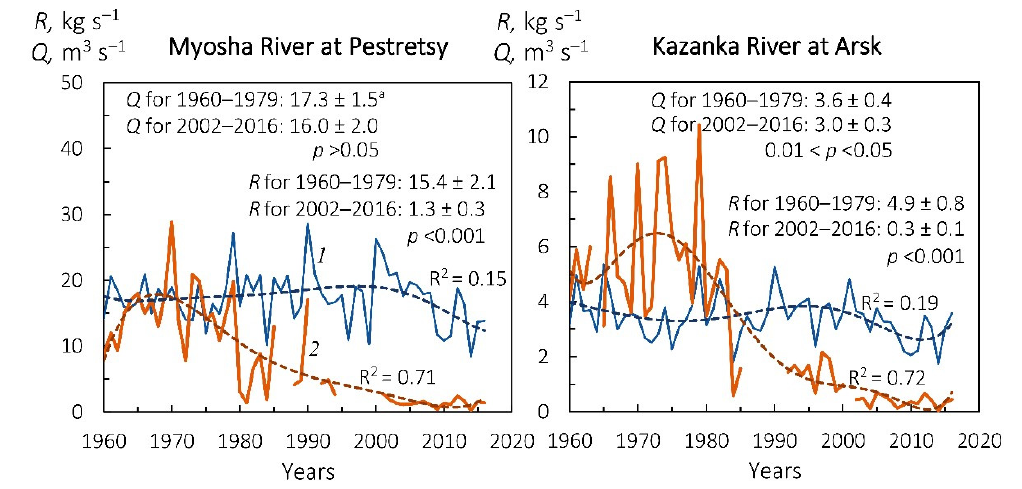
Figure 8. Changes in mean annual water discharge ( Q , 1 ) and suspended sediment load ( R , 2 ) of the Myosha River and Kazanka River (see Figure 2B and Table 1) in 1960–2016, modified from [65]; the dashed line–a sixth-degree polynomial trend. a Hereinafter, a 95% confidence interval.